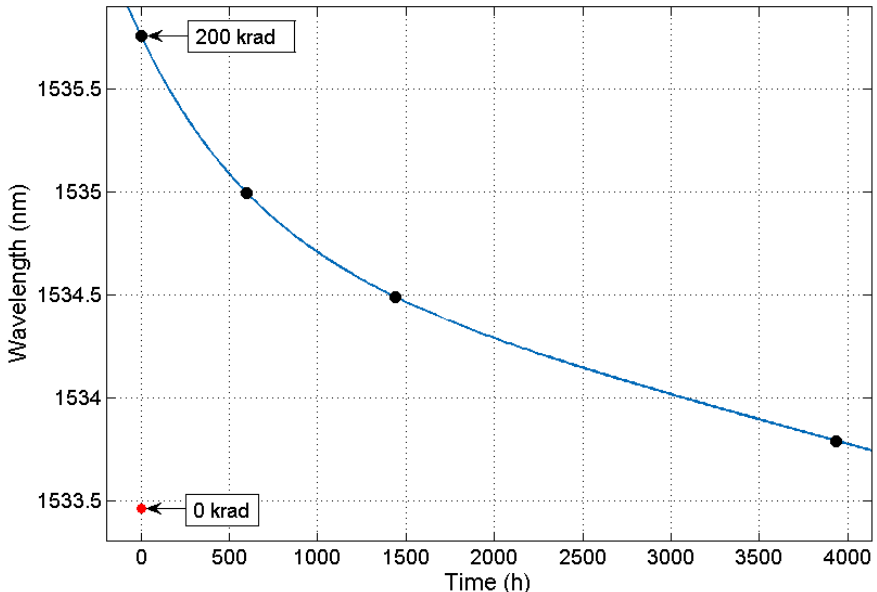
Figure 5. LPFG1 recovery Dip Wavelength after irradiation. Data with 0 krad is depicted for wavelength reference.